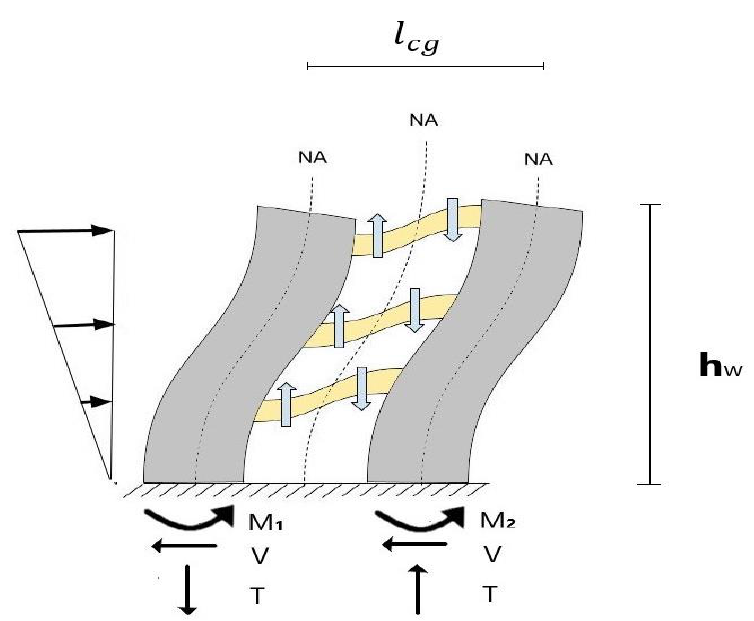
Figure 3. Force development in a CSW system.